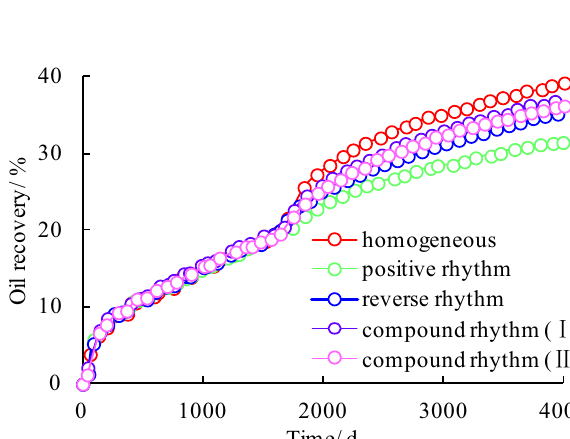
Fig. 8 Oil recovery variation in rhythm reservoirs